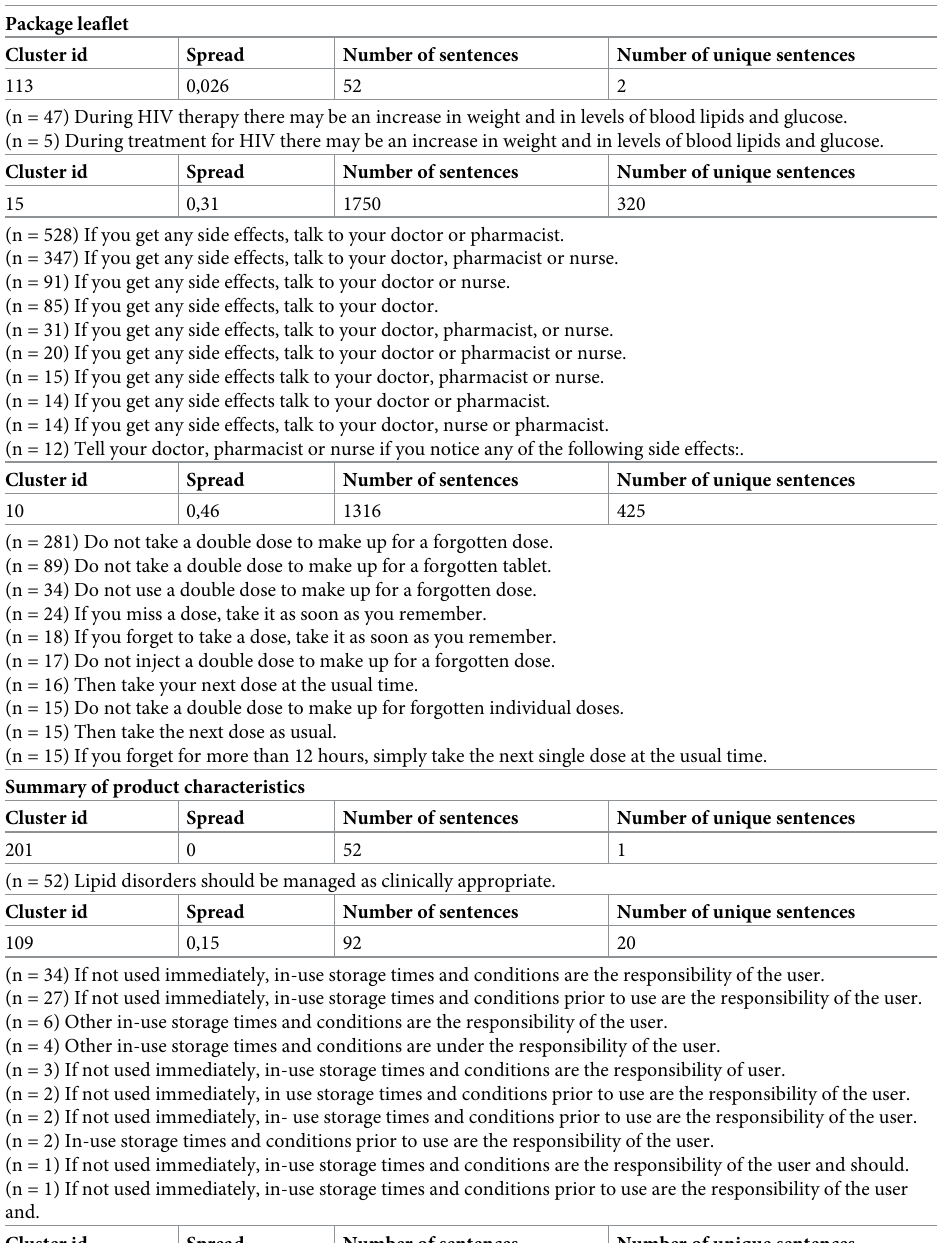
Table 1. Examples of sentence clusters within the PL and SmPC language space. Up to ten variants listed per